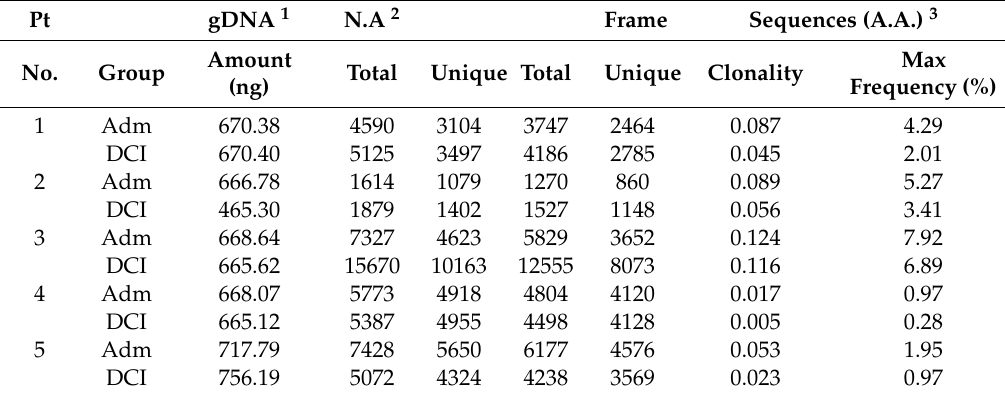
Table 2. TCRB CDR3 repertoire with total sequences, unique sequences, and clonality.